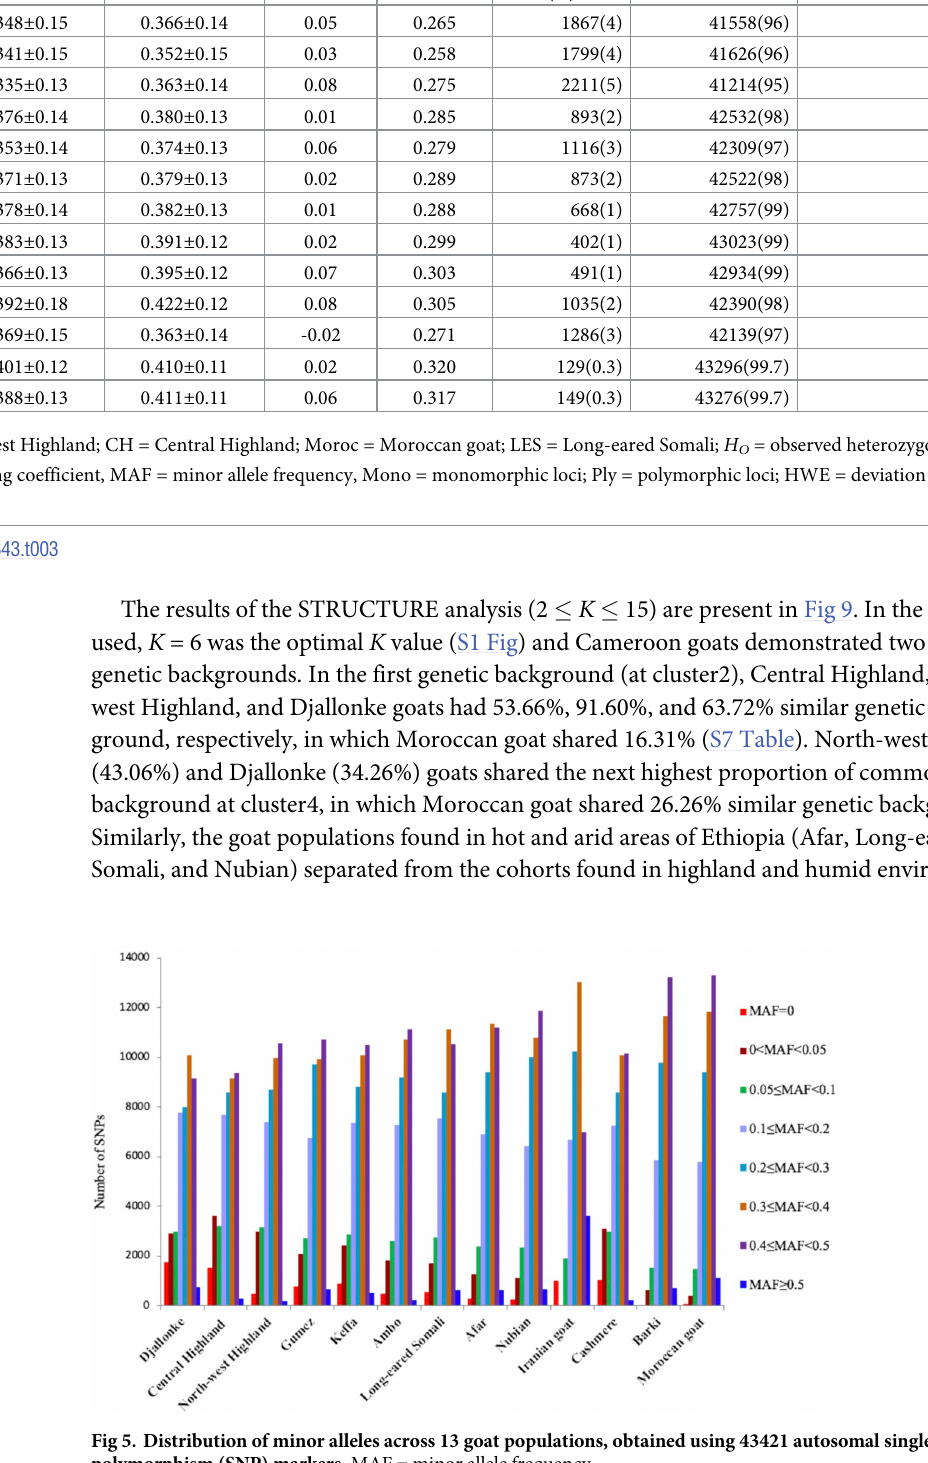
Table 3. Single nucleotide polymorphisms and within-population genetic diversity in the study goat populations.